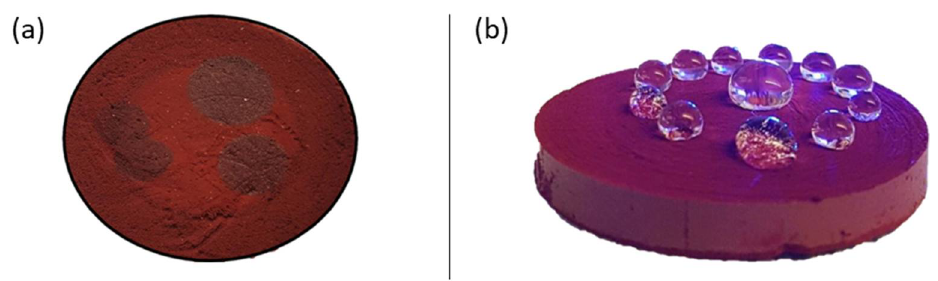
Figure 4. Pictures of ( a ) unfunctionalized RF and ( b ) silylated xerogel (TBS-A) after placement of water